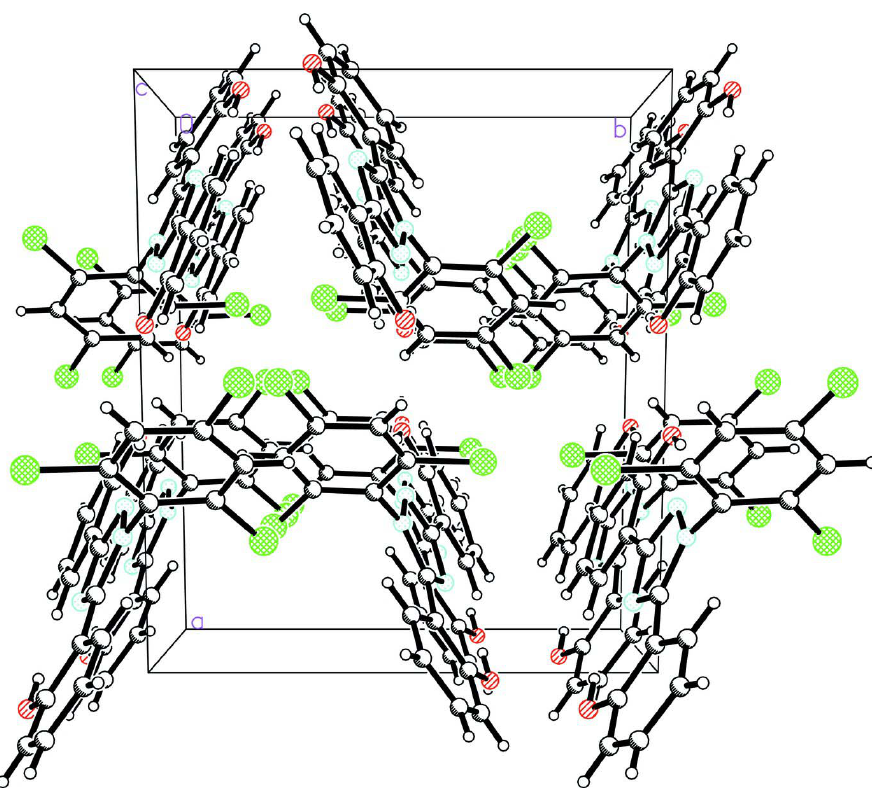
The molecular structure of the title molecule, with the atom-numbering scheme. Displacement ellipsoids are drawn at the 30% probability